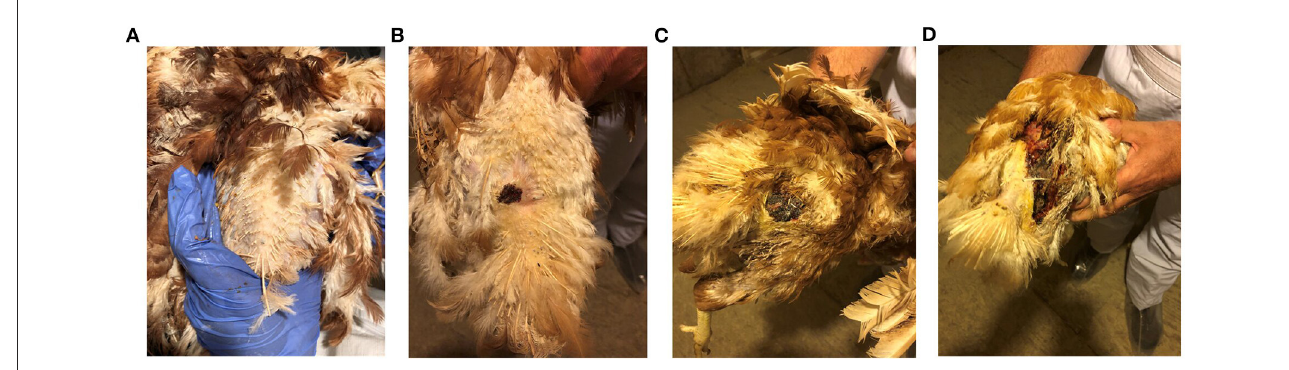
FIGURE1 FUDS lesion scoring. Scores were assessed based on size and involvement in the underlying tissue. Scores ranged from 0 to 3: (A) 0, no lesion; (B) 1, lesion size < 2cm; (C) 2, lesion size 2–6cm; (D) 3, lesions > 6cm.